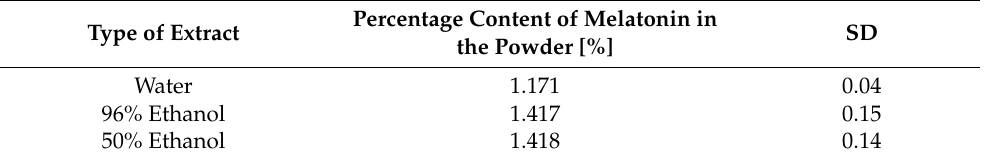
Table 1. The content of melatonin in the extracts from PHT-MLT powder calculated from the corresponding mass chromatograms (SD—standard